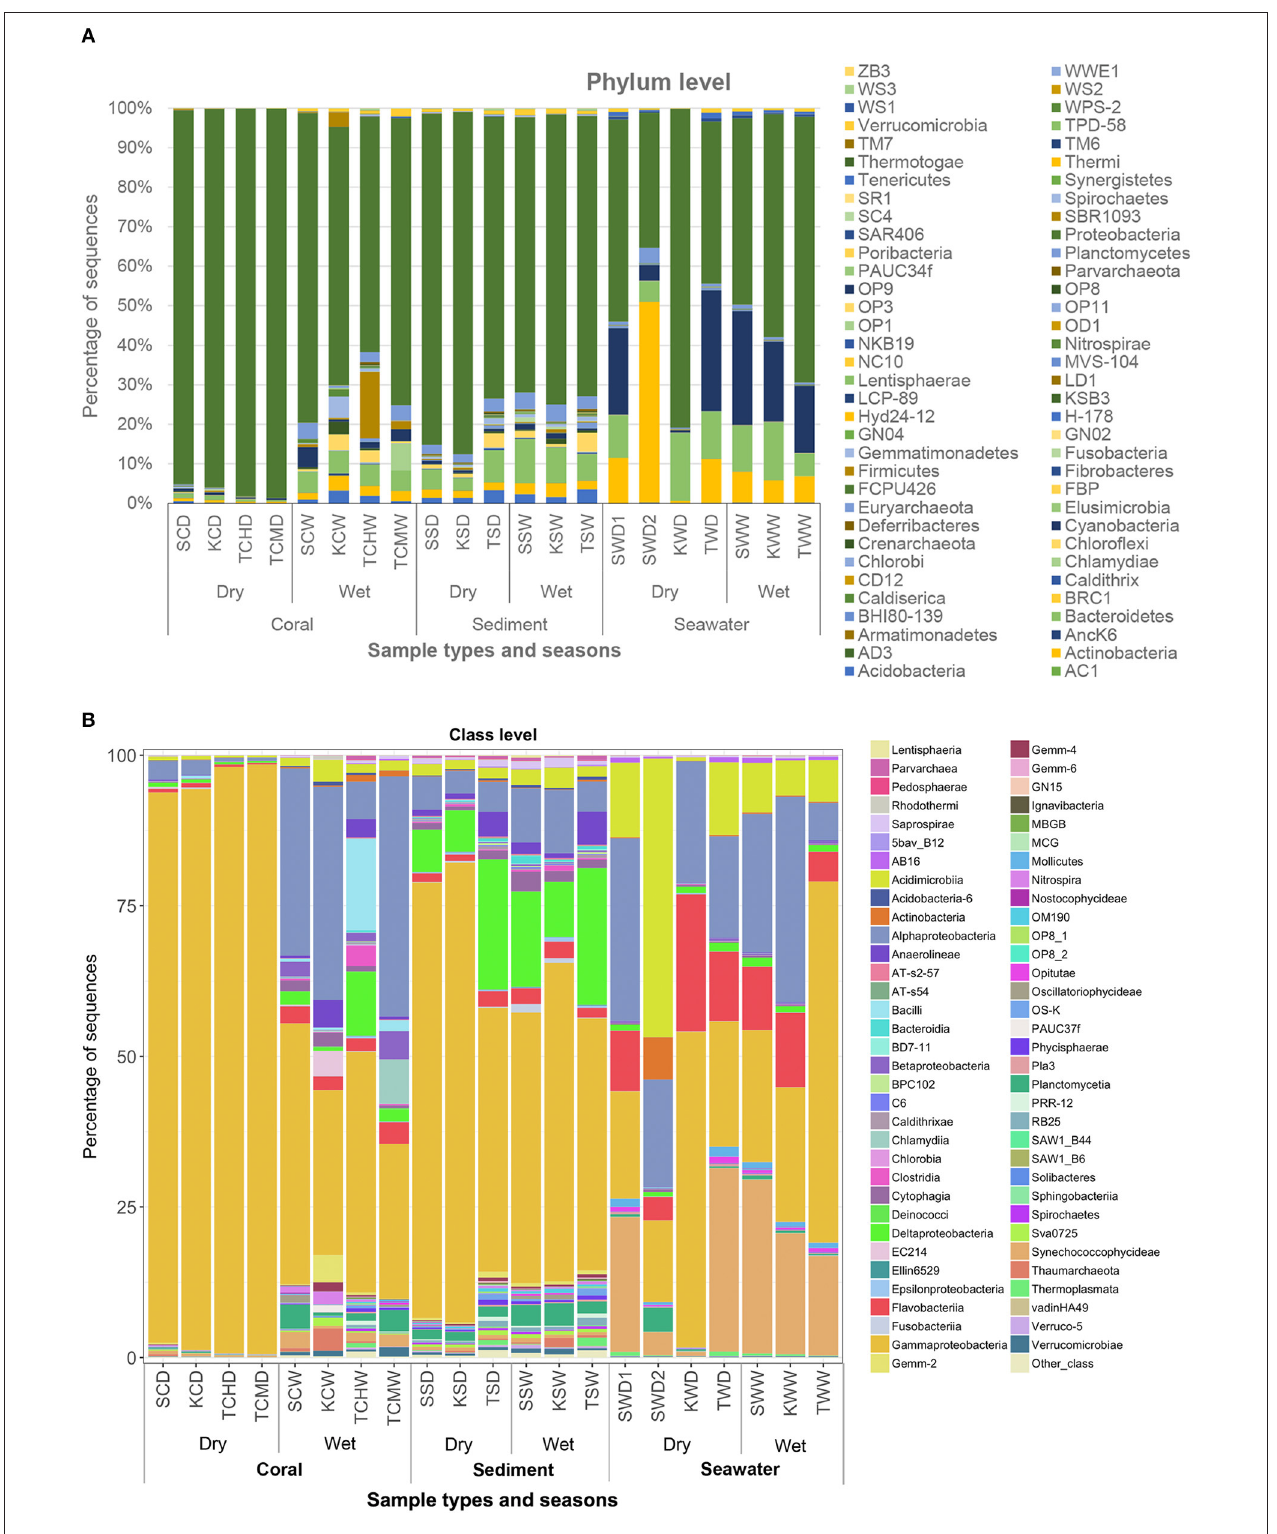
FIGURE 3 | Prokaryote community compositions at levels of phylum (A) and class (B) , of merged B-RISA subgroups with p > 0.01. Other class represents the OTU classes of < 10%.